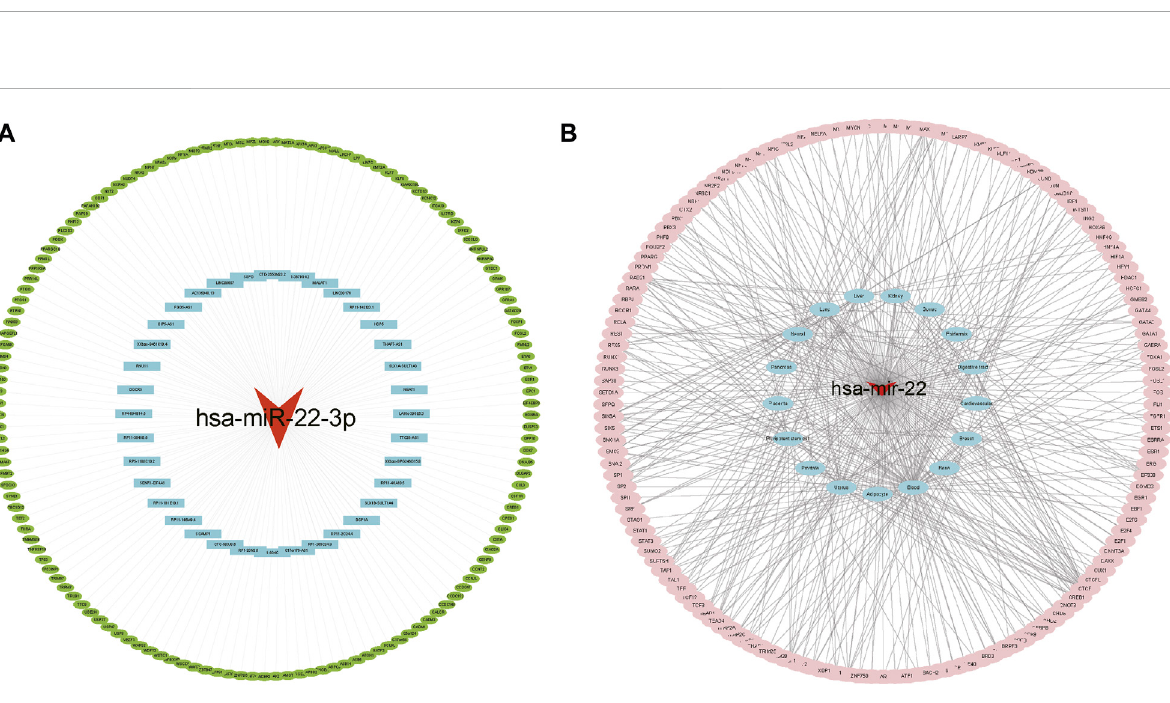
FIGURE 5 Interaction network analysis. (A) ceRNA network analysis. The red triangle represents miRNA, blue represents lncRNA, and green represents target genes. (B) Target gene-transcriptionfactoranalysis.Red representsmiRNA genes, bluerepresentsrelevant diseasetissue,andpinkrepresents transcription